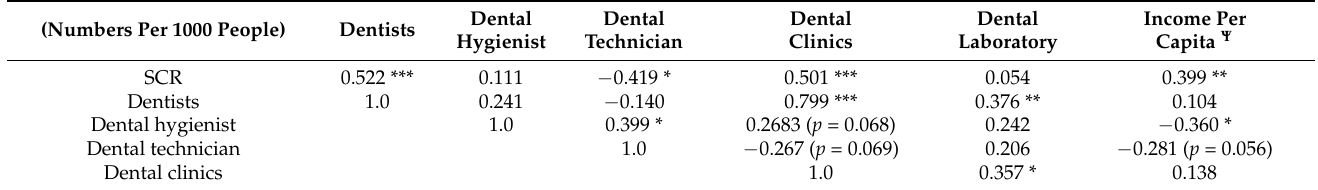
Table 2. Spearman’s correlations between the SCR of total dental receipts and prefectural characteristics in